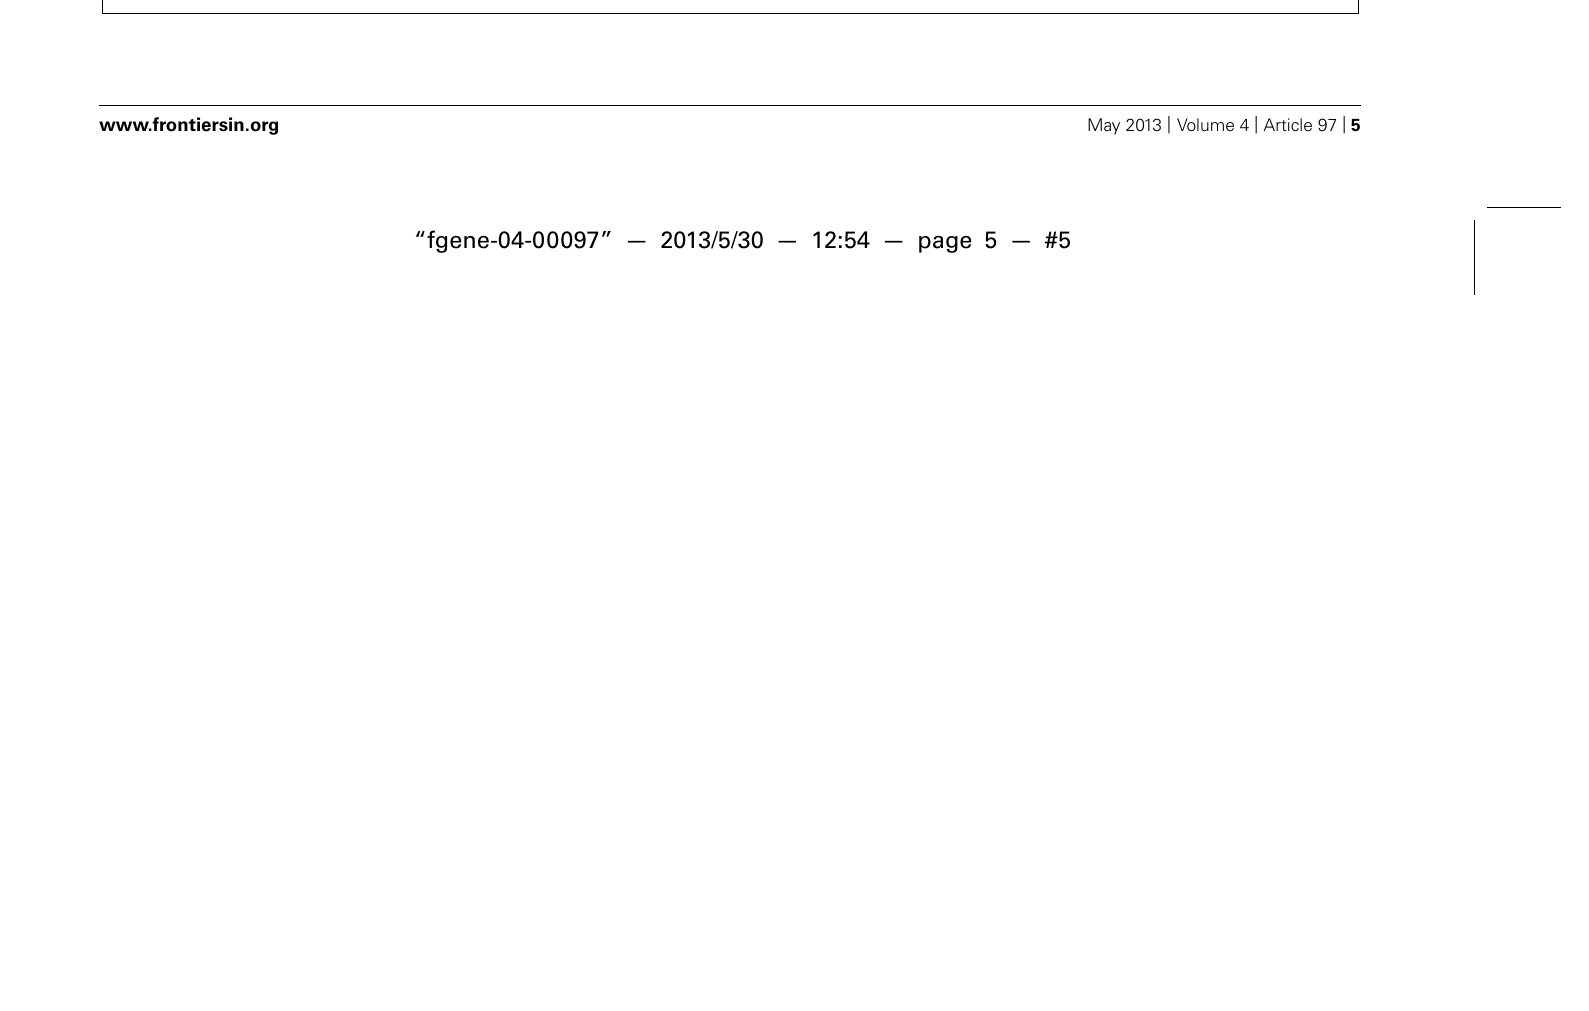
FIGURE 4 | Relationship between expression of (A) MITF-M andAxl, and (B) MITF-M and N-cadherin normalized to β -actin expression. The lines indicate best-fit